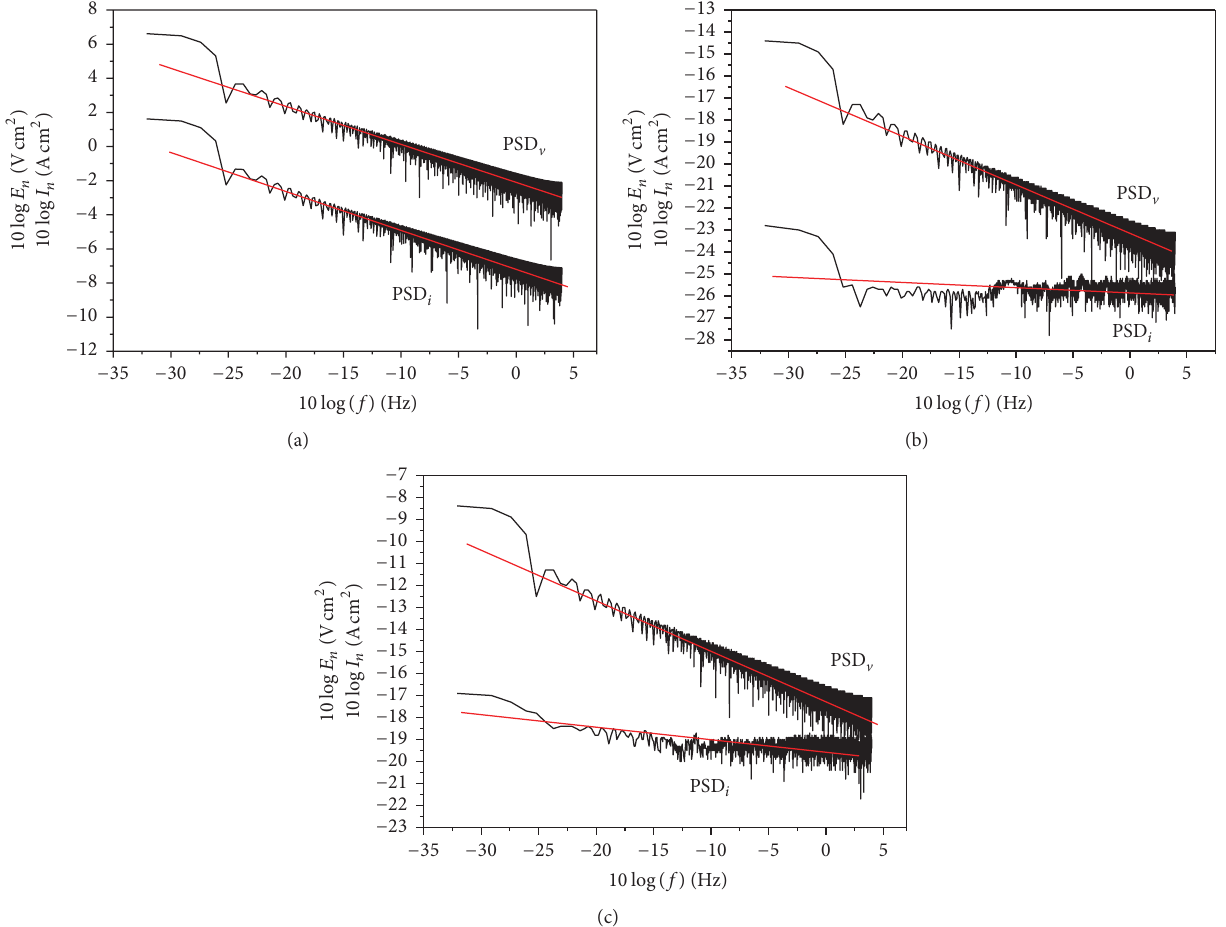
Figure 6: Power spectral density (current and voltage) of CS (a) and blank (b) in presence of P2APH and (c) RP2APH (1.0mM) in 1M HCl.